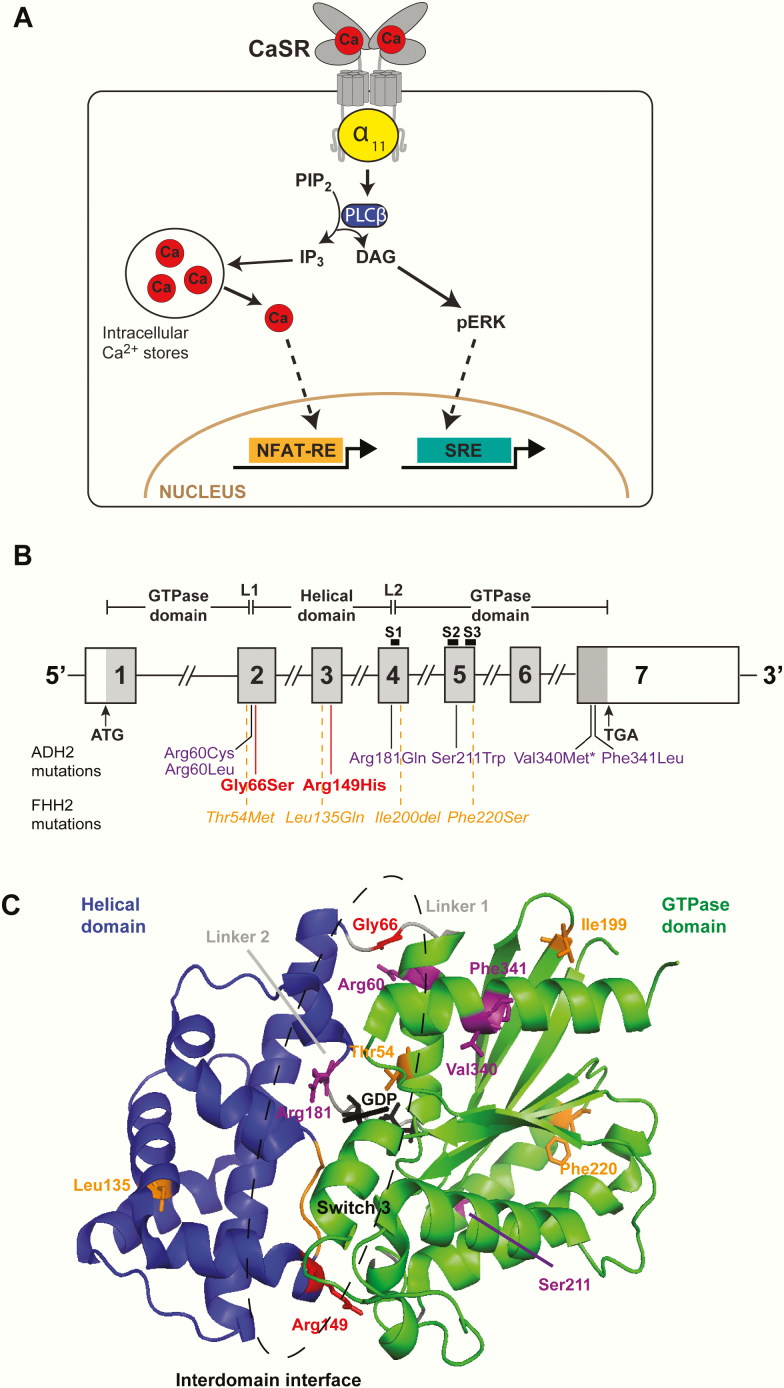
(A) Diagrammatic representation of the CaSR signaling pathways. Calcium (red circle, Ca) binding to CaSR (gray) activates Gα 11 (yellow)-dependent stimulation of phospholipase C-β (PLCβ) (dark blue), which catalyzes formation of inositol 1,4,5-trisphosphate (IP3) and diacylglycerol (DAG) from phosphatidylinositol 4,5-bisphosphate (PIP2). IP3 mediates calcium mobilization from intracellular stores, whereas DAG activates the pERK signaling cascade. Gene transcription mediated by intracellular calcium and pERK can be measured using nuclear factor of activated T-cell response element (NFAT-RE) and serum response element (SRE) containing luciferase reporter constructs, respectively. (B) Schematic representation of the genomic organization of the human GNA11 gene that comprises 7 exons, with coding regions shaded gray and untranslated regions represented by open boxes. Loss-of-function Gα 11 mutations (orange), have been reported in 4 FHH2 probands (2, 15, 16), and 6 gain-of-function Gα 11 mutations (purple), reported in 7 ADH2 probands (2, 9–12). The Val340Met Gα 11 mutation (asterisk) has been reported in 2 unrelated ADH2 probands (11, 12). This manuscript describes 2 ADH2 mutations, p.Gly66Ser and p.Arg149His (red). The GTPase domain (encoded by portions of exon 1, 2, and 4, and the whole of exons 5–7) is connected to the helical domain (encoded by portions of exon 2 and 4, and the whole of exon 3) by the linker 1 (L1) and linker 2 (L2) peptides. Three flexible switch regions (S1-S3), which undergo conformational changes upon Gα 11 activation, are encoded by exons 4 and 5. (C) Homology model of the Gα 11 protein based on the structure of Gα q in complex with PLCβ (PDB: 3OHM) (26). The Gα helical (blue) and GTPase (green) domains are connected by the linker 1 and linker 2 peptides (gray). GDP (black) is bound at the interdomain interface (dashed ellipse). Switch 3 is shown in orange, and the Gly66 and Arg149 Gα 11 residues that are mutated in families 1 and 2 (Fig. 2), respectively, shown in red. Residues previously reported to harbor 6 ADH2 and 4 FHH2 Gα 11 mutations are shown in purple and orange, respectively (2, 9–12, 15, 16). Adapted from Hannan FM et al J Mol Endocrinol 2016 Oct;57 (28):R127-42.